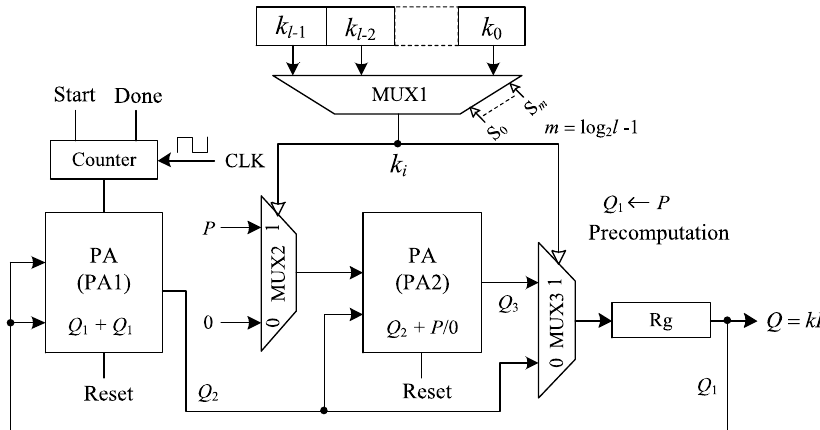
Figure 7. Proposed hardware architecture for